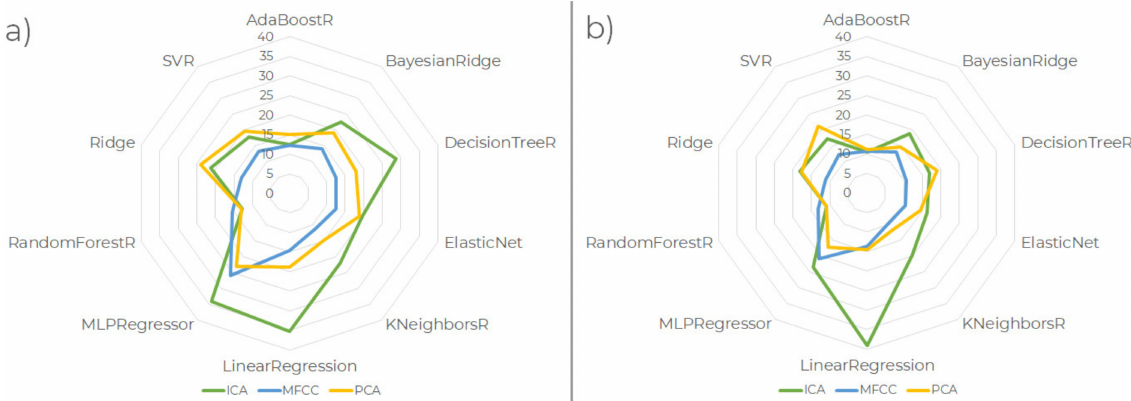
Figure 3. Results obtained after grid search for model selection. Values of mean absolute error ( a ) and mean absolute percentage error ( b ) are reported.